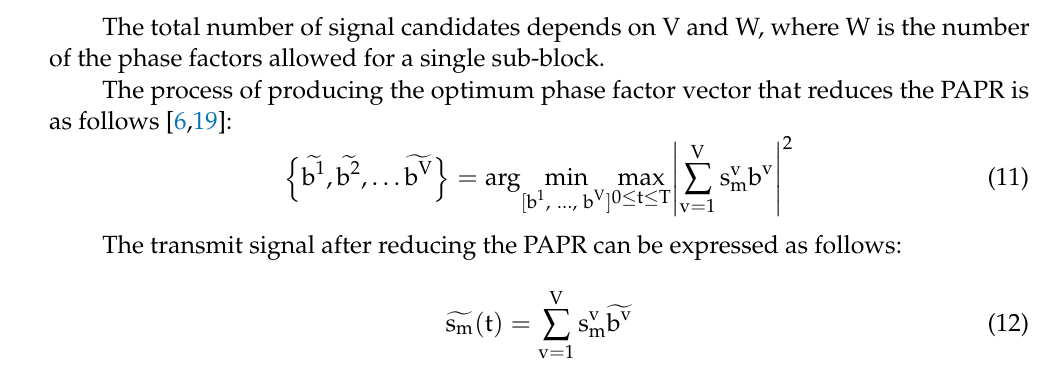
Figure 3. PTS (partial transmit sequence) scheme at the transmitter for OFDM (orthogonal frequency division